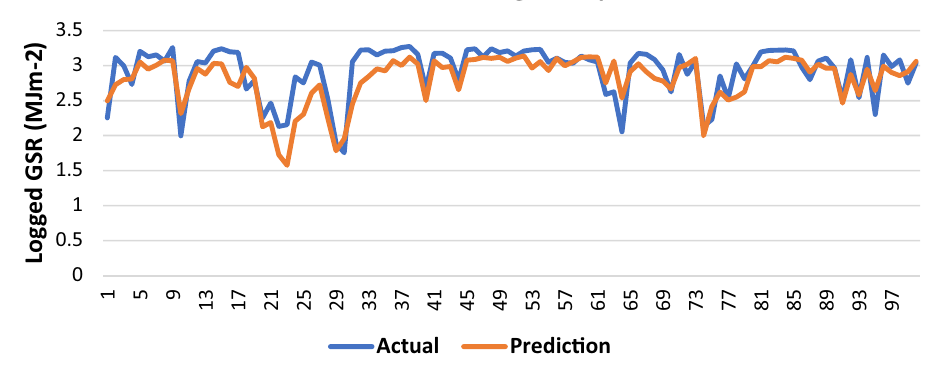
Figure 9. Graph of Actual and Predicted GSR (Model III—LM).